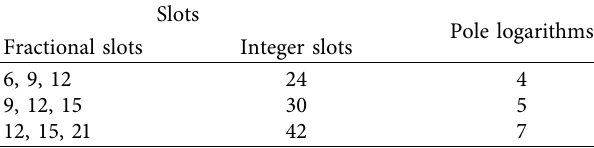
Table 1: Matching of actuator slots and poles.